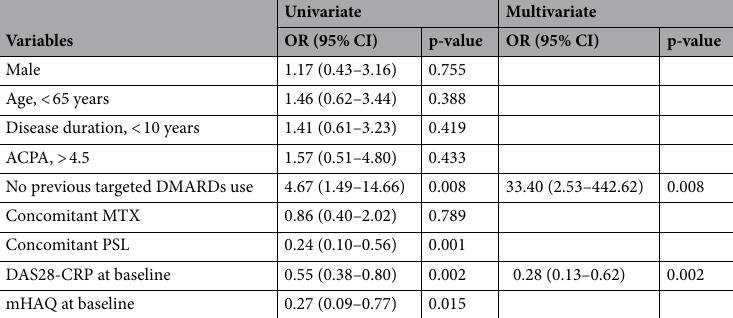
Table 2. Predictive factors for LDA achievement at week 24 (univariate and multivariate logistic regression analyses). ACPA anti-citrullinated peptide antibody, targeted DMARDs biological or targeted synthetic disease- modifying antirheumatic drugs, MTX methotrexate, PSL prednisolone, DAS28 Disease Activity Score in 28 joints, mHAQ modified health assessment